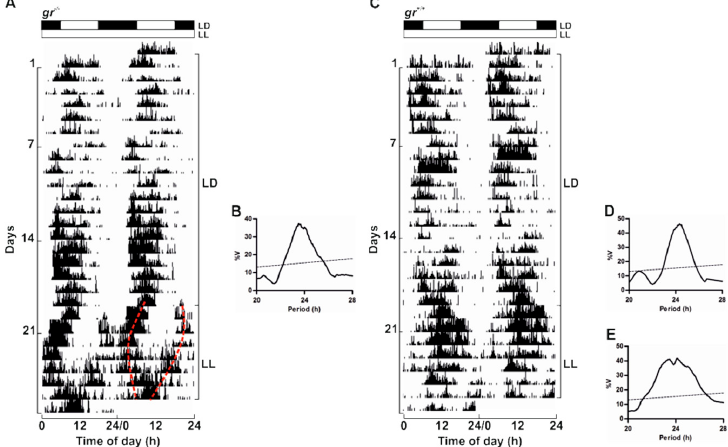
Figure 6. Circadian activity rhythms of gr +/+ and gr − / − adult zebrafish. Representative actograms ( A , C ) of adult zebrafish gr +/+ and gr − / − subjected to 12:12 LD cycles and then to LL. Activity records in the last 10 days of LD cycles ( B , D ) and of LL ( E ) were subjected to χ 2 periodogram analysis. Dotted lines marked the splitting of the rhythm into two independent components with periodicity in the circadian range. For more details, see Figures 2 and 5.